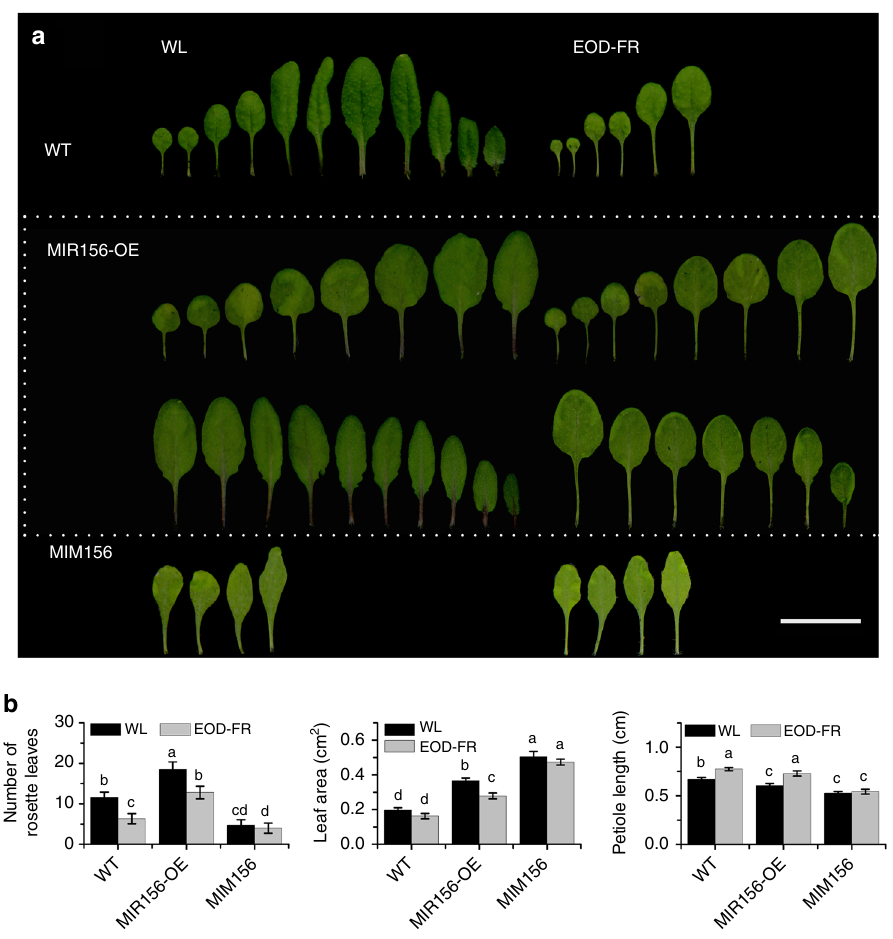
Fig. 2 MIR156 overexpression represses attenuated SAS responses in adult Arabidopsis plants. a Comparison of the rosette leaf number, leaf blade area, and petiole length of the fi rst and second leaf between MIR156 overexpessors, MIM156 , and WT plants under normal high R:FR (WL) or simulated shade (EOD- FR) conditions. Eight-day-old seedlings were moved into the soil and grown under WL with or without EOD-FR treatment for 4 weeks. Bar = 2 cm. b Quanti fi cation of the rosette leaf number, leaf blade area, and petiole length of MIR156 overexpressors, MIM156 , and WT plants under WL or EOD-FR conditions. Values shown are mean ± SD ( n = 12). Letters indicate signi fi cant differences by two-way